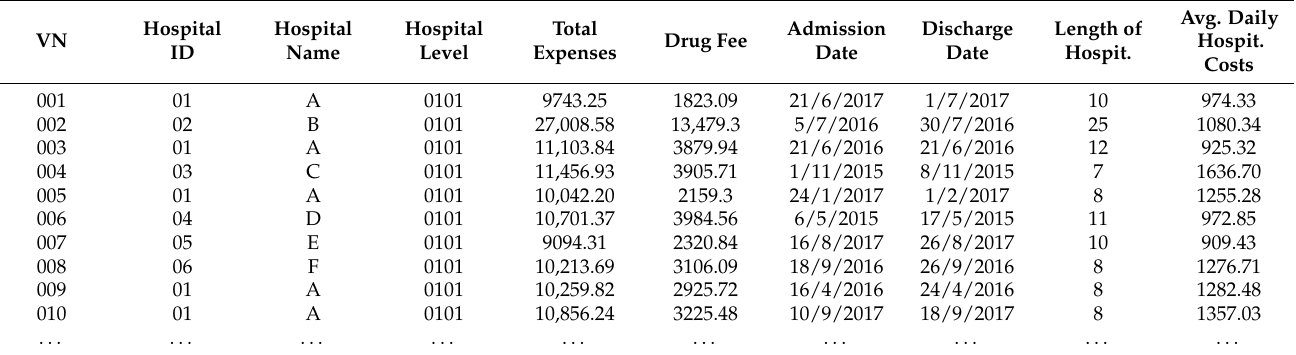
Table 4. Example of test data.